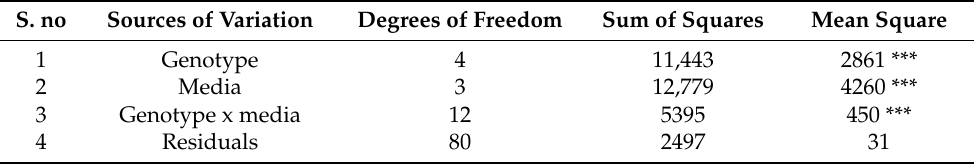
Table 2. Two-way ANOVA for effects of media and genotype on callus